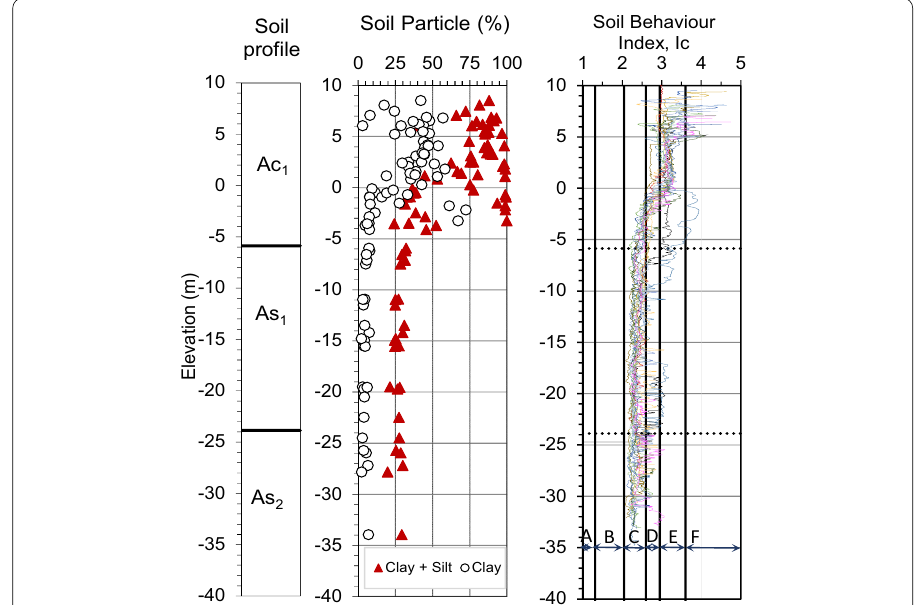
Fig. 1 Soil profile of Dhaka soil with particle percentage and soil behaviour index ( Ic ) with depth